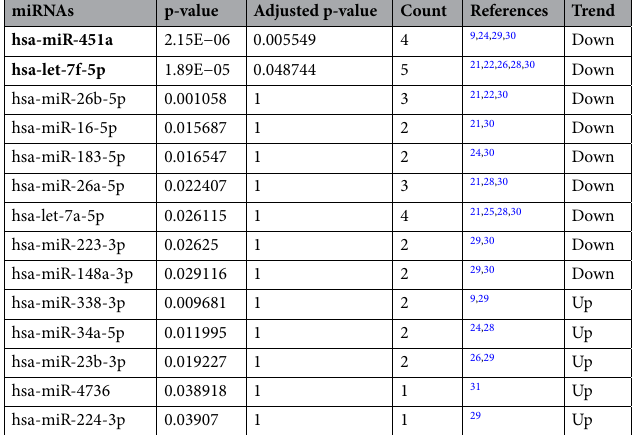
Table 1. Meta-signature miRNAs in sALS patients. Significant values are in